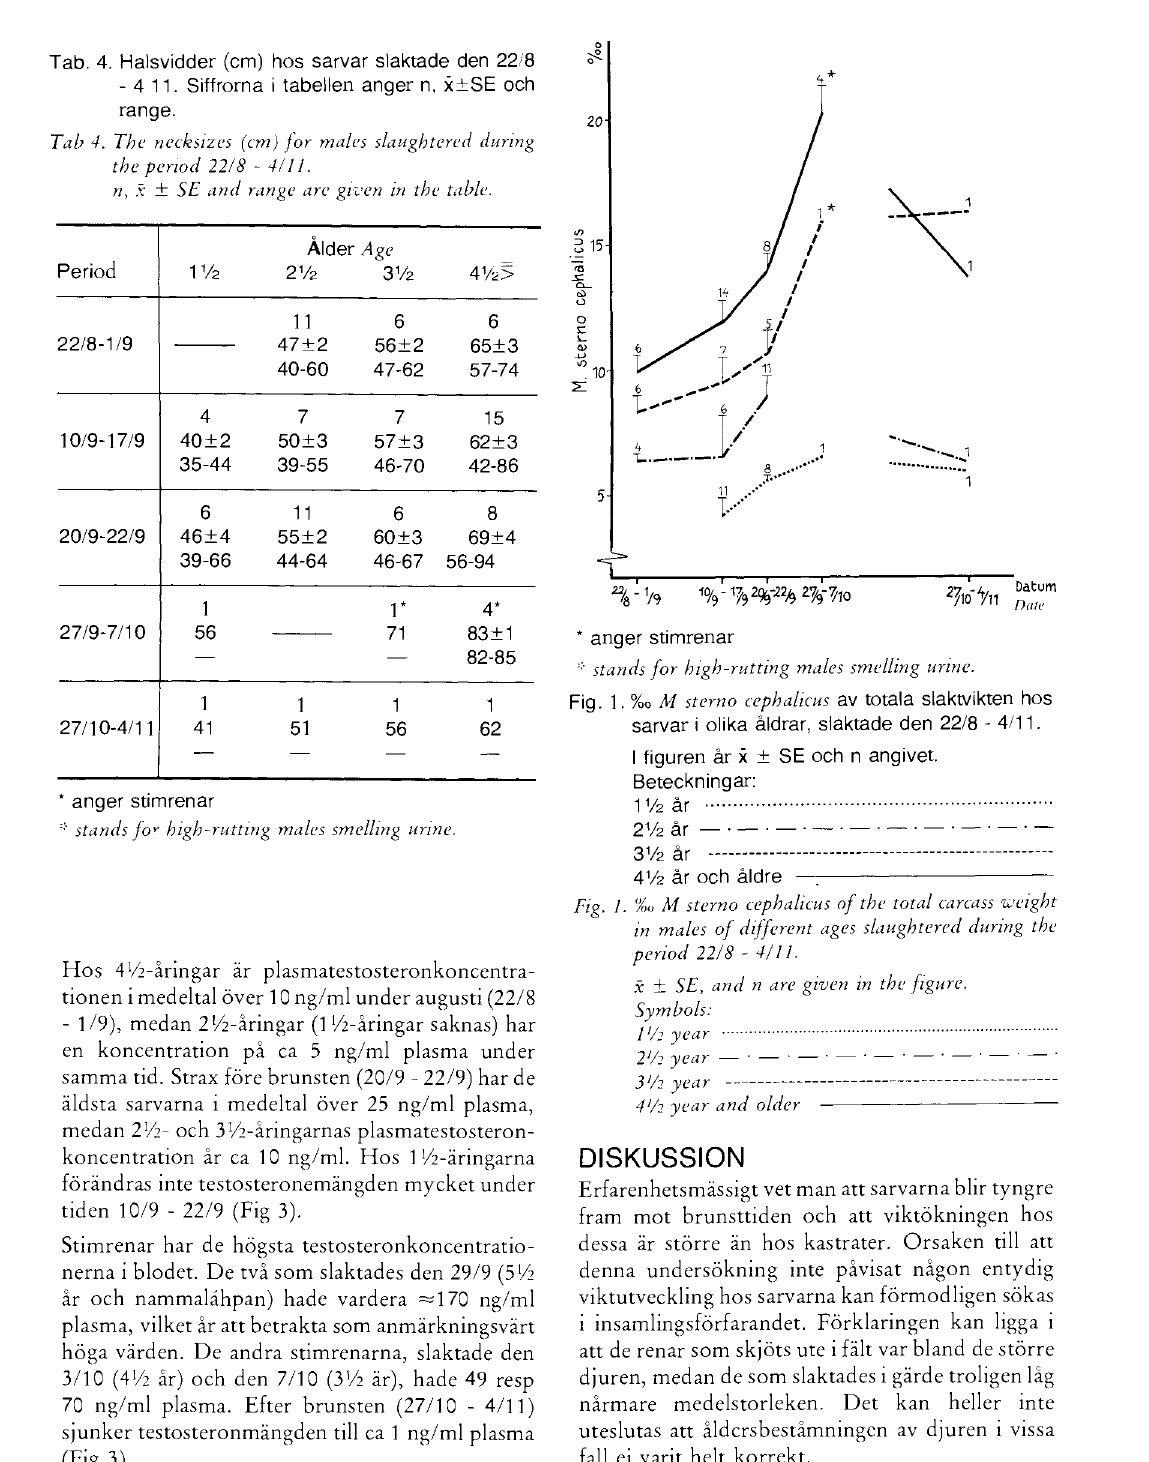
fig, 1. %» M stemo cephalicus of the total carcass leetght in males of different ages slaughtered during the penod 22/8 - 4/11. x ± SE, and n are given in the figure. Symbols: V /2